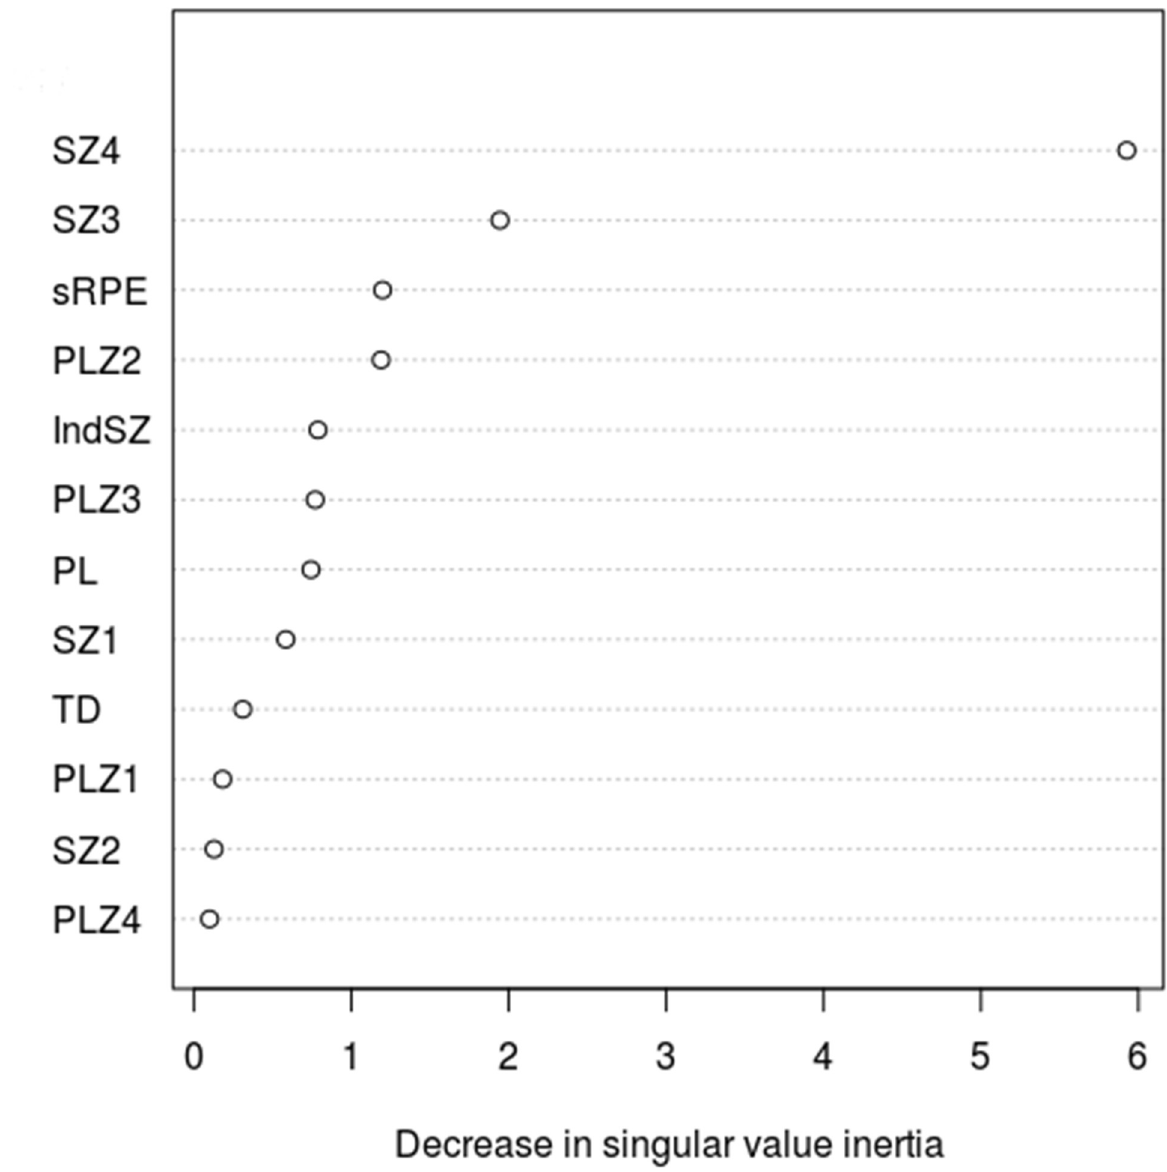
Fig 2. Variable importance plot showing the decrease in singular value inertia attributable to each predictor